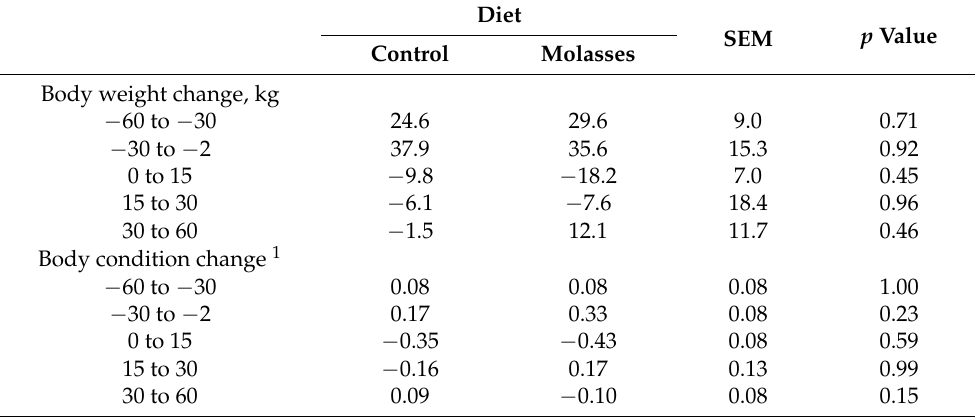
Table 9. Body weight change and body condition change for cows fed control or molasses diets during a 60 day dry period (Experiment